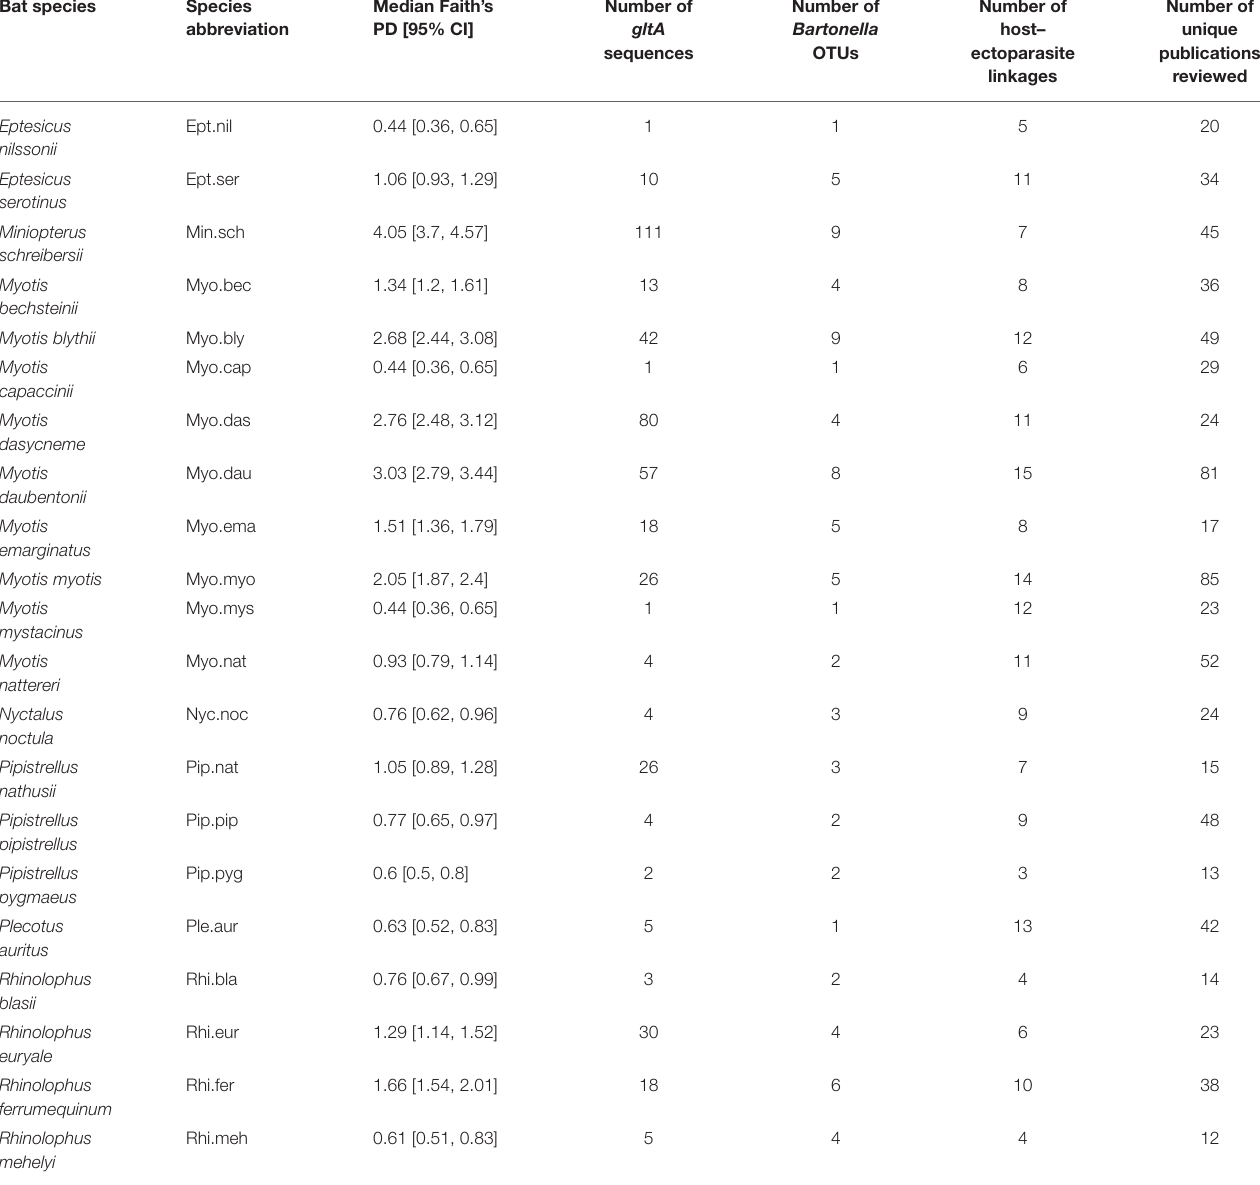
TABLE 1 | Summary of Bartonella phylogenetic diversity for 21 European bat species included in our